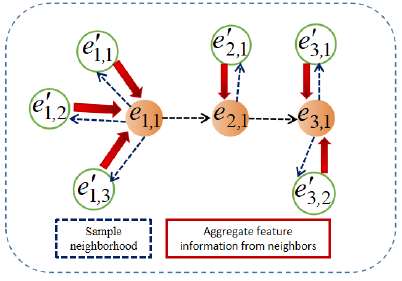
Figure 2. GraphDIVA path feature generation process diagram.